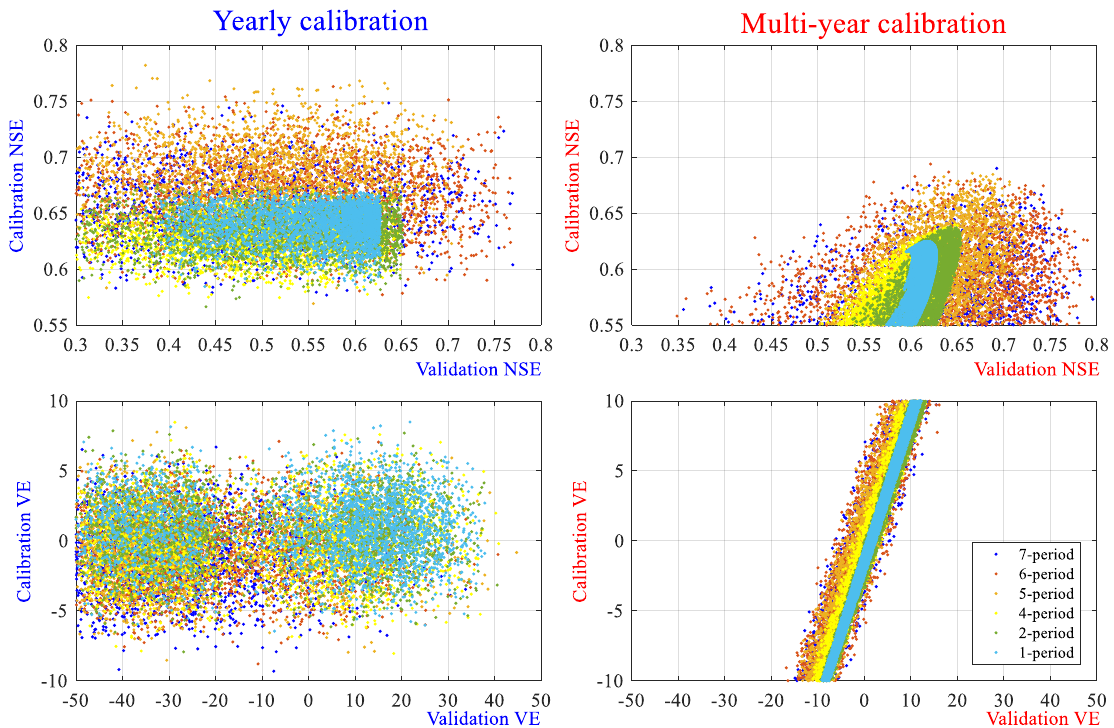
Figure 5. Scatter plots of the Nash-Sutcliffe coefficient (NSE) (upper) and the relative volume error VE (lower) of calibration versus validation for different calibration strategies. The left subplots present the yearly calibration and the right subplots present the multi-Year calibration.